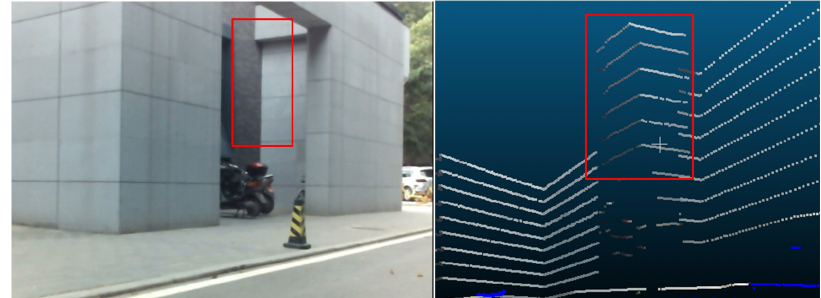
Figure 15. Detail of a colorized point cloud: the color of the wall changes correctly at the edge. The left and right part shows the image and the colorized point cloud, respectively.